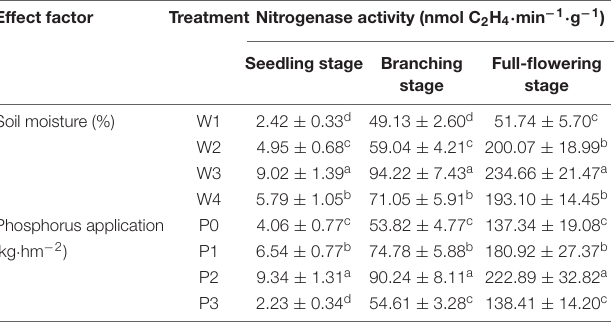
TABLE 1 | Nitrogenase activity of Chinese milk vetch (CMV) under different soil moisture contents or levels of added phosphorus. Effect factor